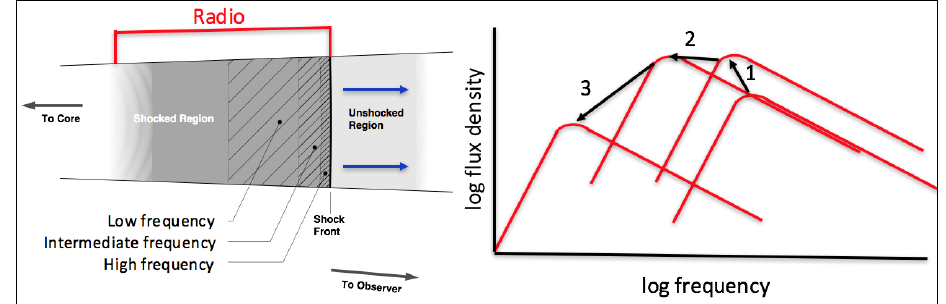
Figure 2. Left: Sketch of the Marscher and Gear shock model [37]. The emitting volume increases with decreasing frequency. Right: Sketch of the evolution of the continuum spectrum according to the model. Stage 1 occurs when inverse Compton energy losses dominate, stage 2 when synchrotron losses dominate, and stage 3 when adiabatic expansion is the primary cooling mechanism.